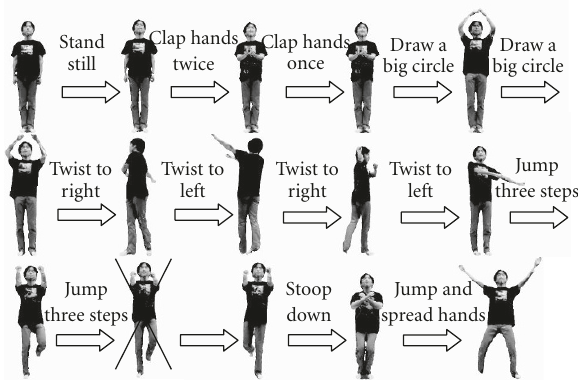
Figure 7: First 14 segmentation points of sequence #2-1. Image with cross-stands for oversegmentation.